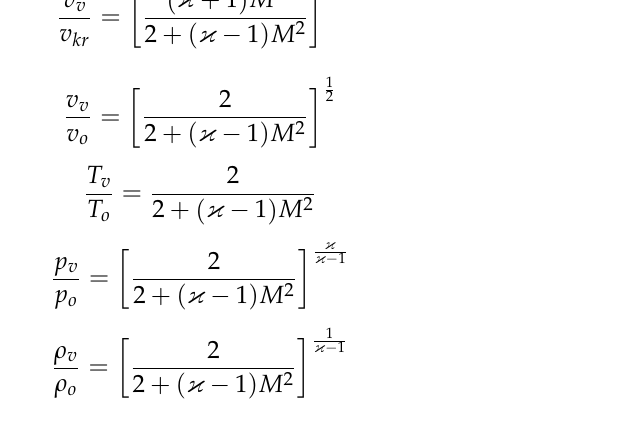
Figure 8. Laval nozzle—Linear shape. Reprinted from ref.